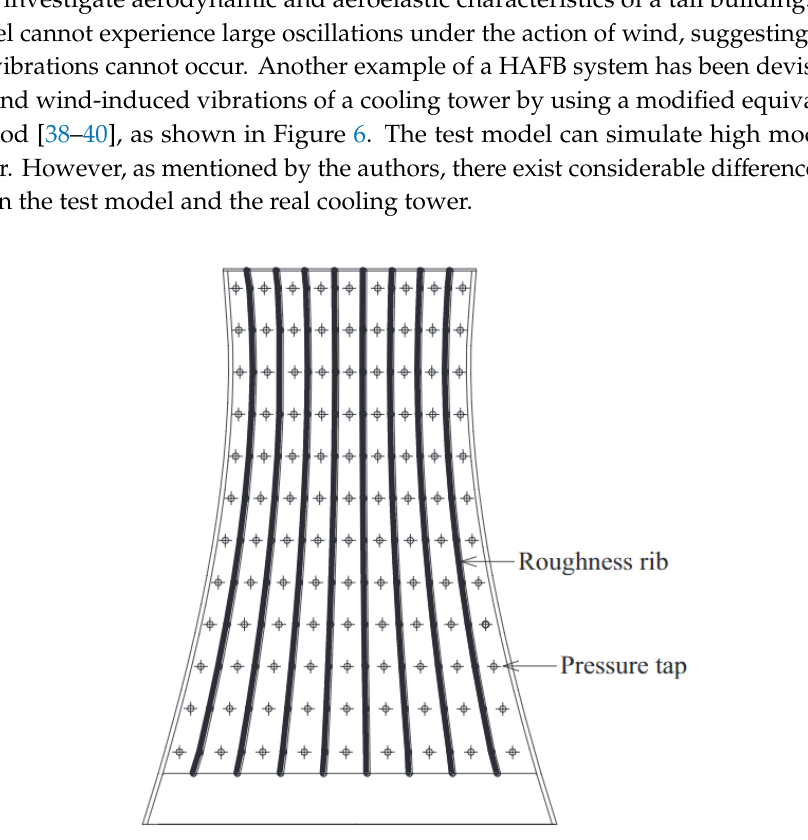
Figure 6. A HAFB model of a cooling tower [39].